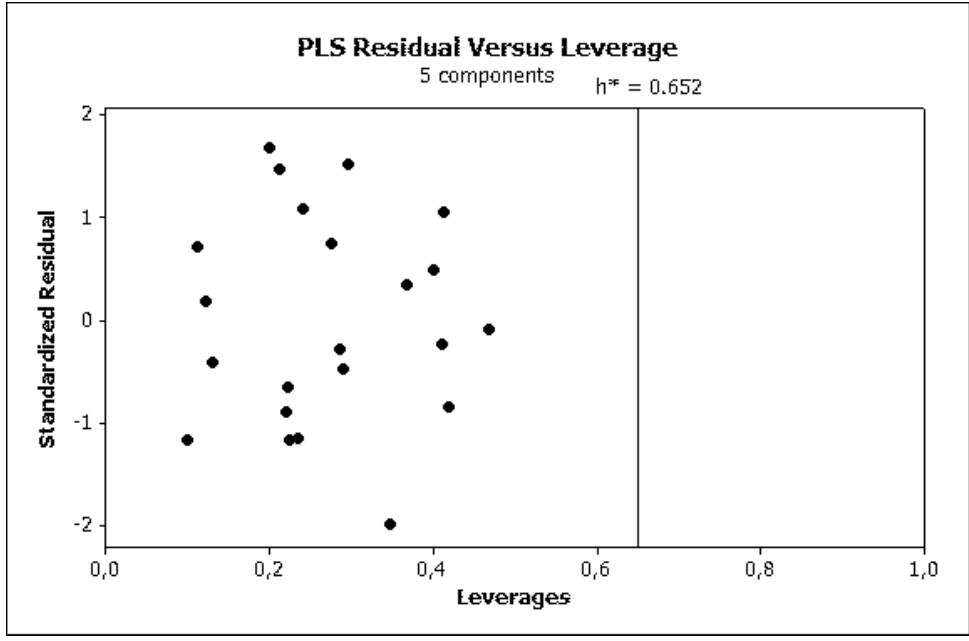
Figure 3. PLS residual vs. leverage (Equation (10)).